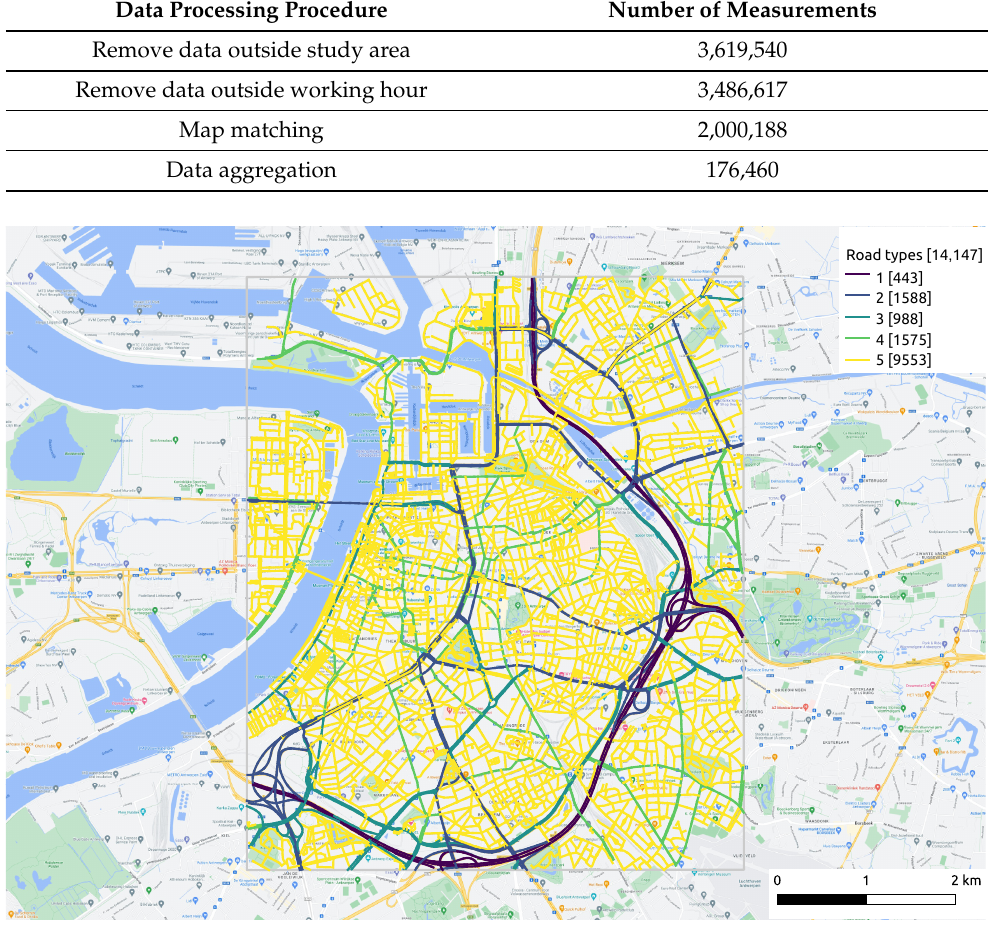
Figure 5. The distribution of distinct road types. The quantity of different road types of road segments is shown by the numbers marked in